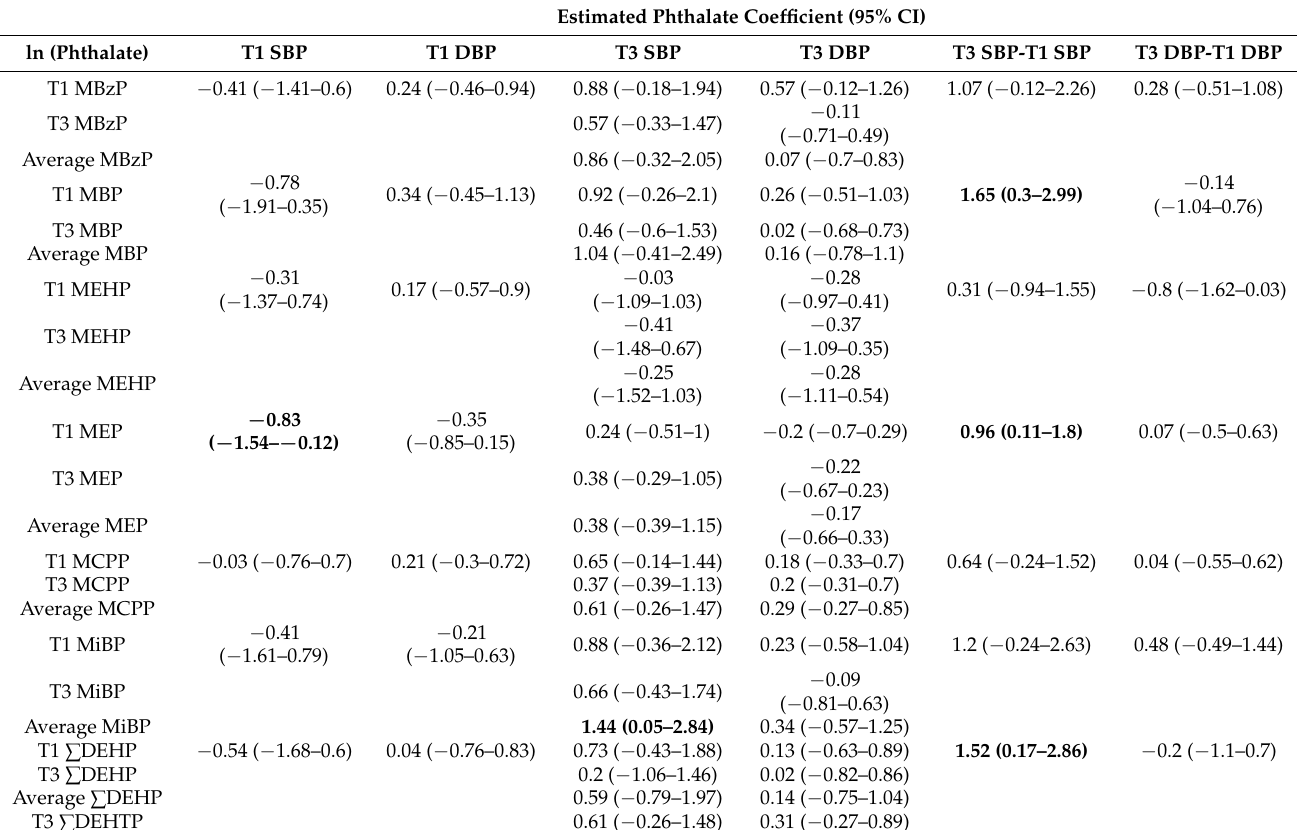
Table 3. Multivariable linear regression coefficients for first- (T1) and third-trimester (T3) blood presScheme